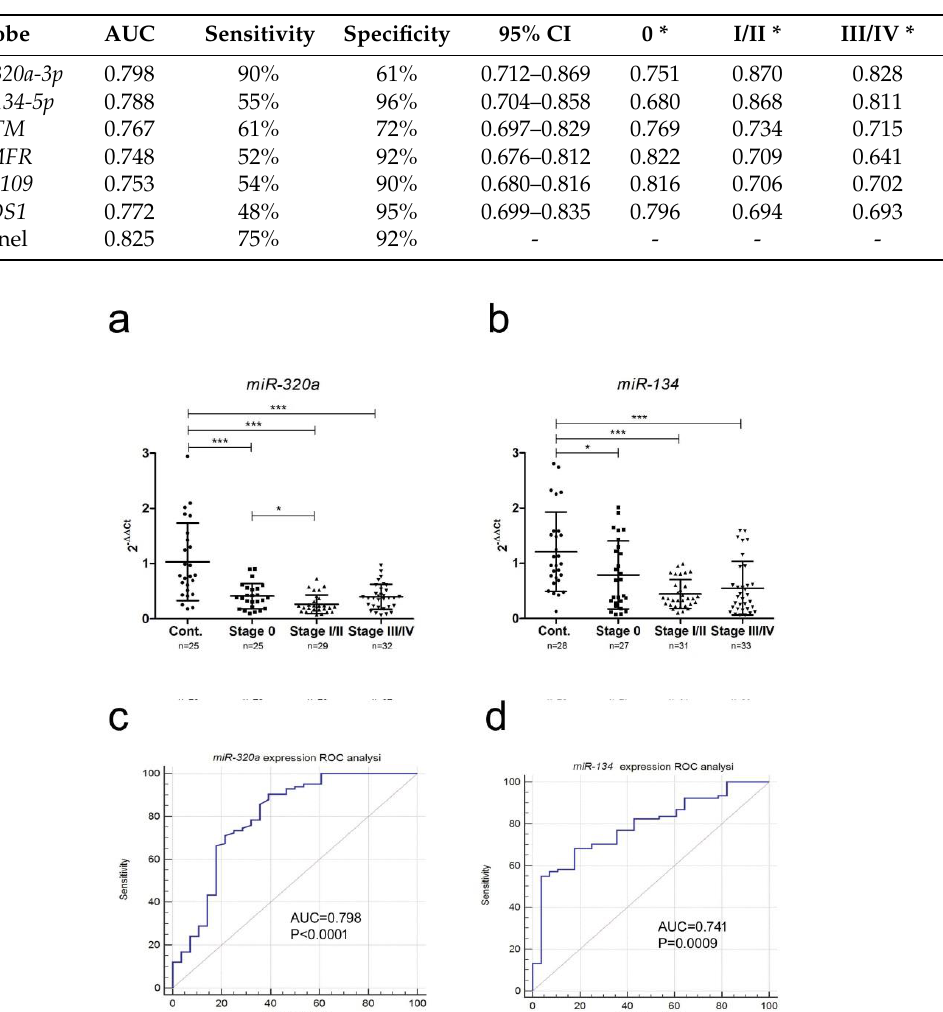
Table 3. ROC analysis values of expression levels of differentially expressed miRNAs and gene fragments. * AUC values of different stage vs. control sample. Panel was a combination of ATM , AMFR , and SOS1 .